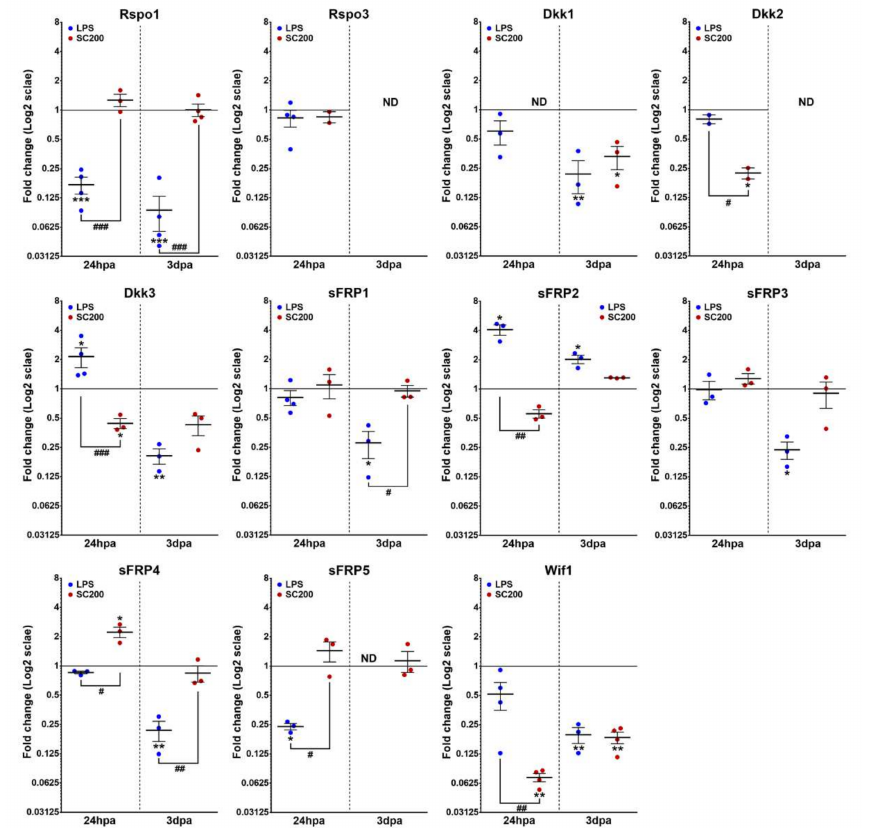
Figure 4. mRNA expression analysis of Wnt inhibitors and modulators in LPS- or SCE-activated microglia and compared to non-activated basal conditions. The figure shows mRNA expression data corresponding to different detectable Wnt signaling inhibitors and modulators in activated microglial cells either with 100 ng/mL of lipopolysaccharide (LPS) or with 200 µ g/mL of lesioned spinal cord extract (SCE). Data represent 2 ∆∆ Ct mean ± SEM. * indicate differences between treated cells vs. non- activated. # indicate differences between treatments (LPS vs. SCE). * p < 0.05; ** p < 0.01; *** p < 0.001; # p < 0.05; ## p < 0.01; ### p < 0.001. hpa: hours post-activation; dpa: days